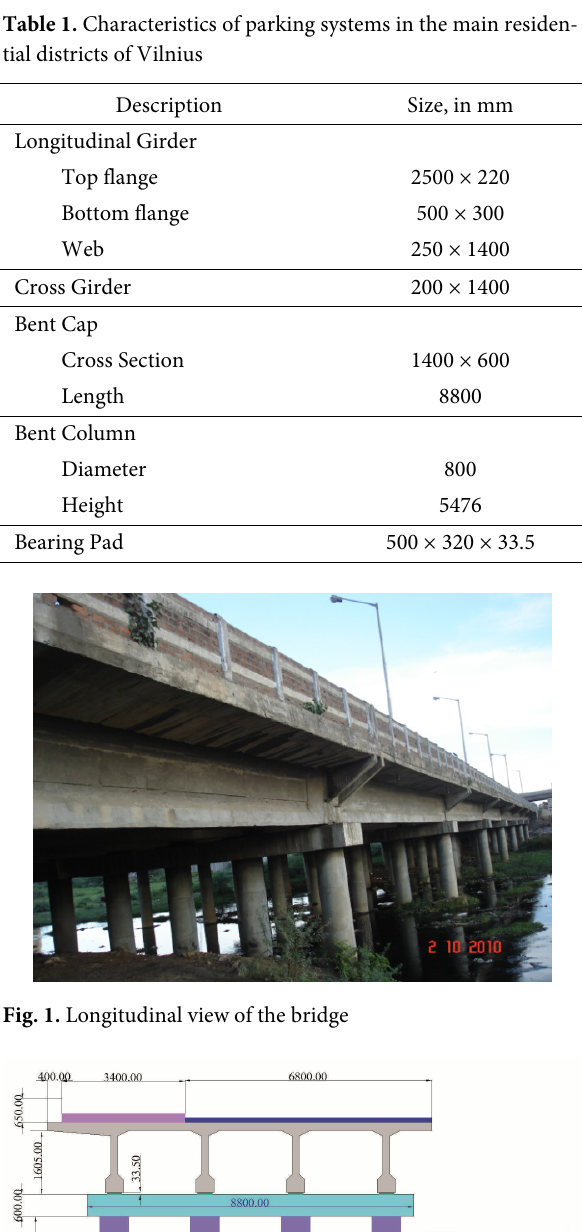
Table 1. Characteristics of parking systems in the main residen-